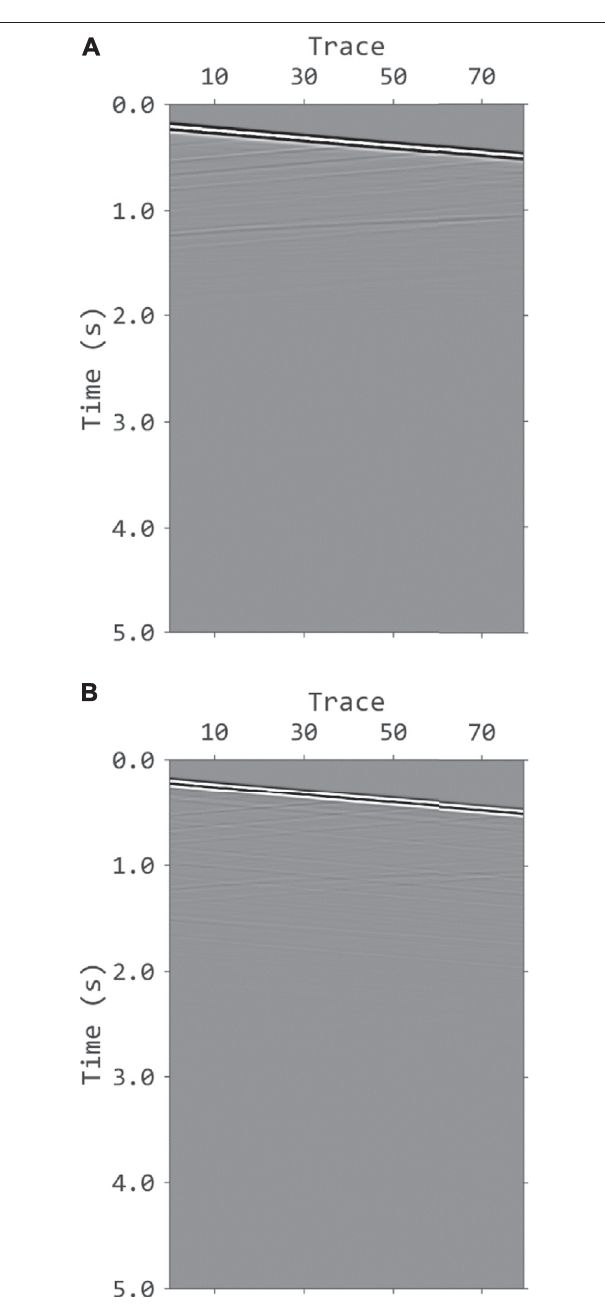
FIGURE 3 | The common shot gathers generated from the Sigsbee 2A model. (A) The generated data without free-surface – related multiples, which contains downgoing direct waves and upgoing primaries. (B) The gathers generated with free surface, which contains direct waves, primaries and free-surface related